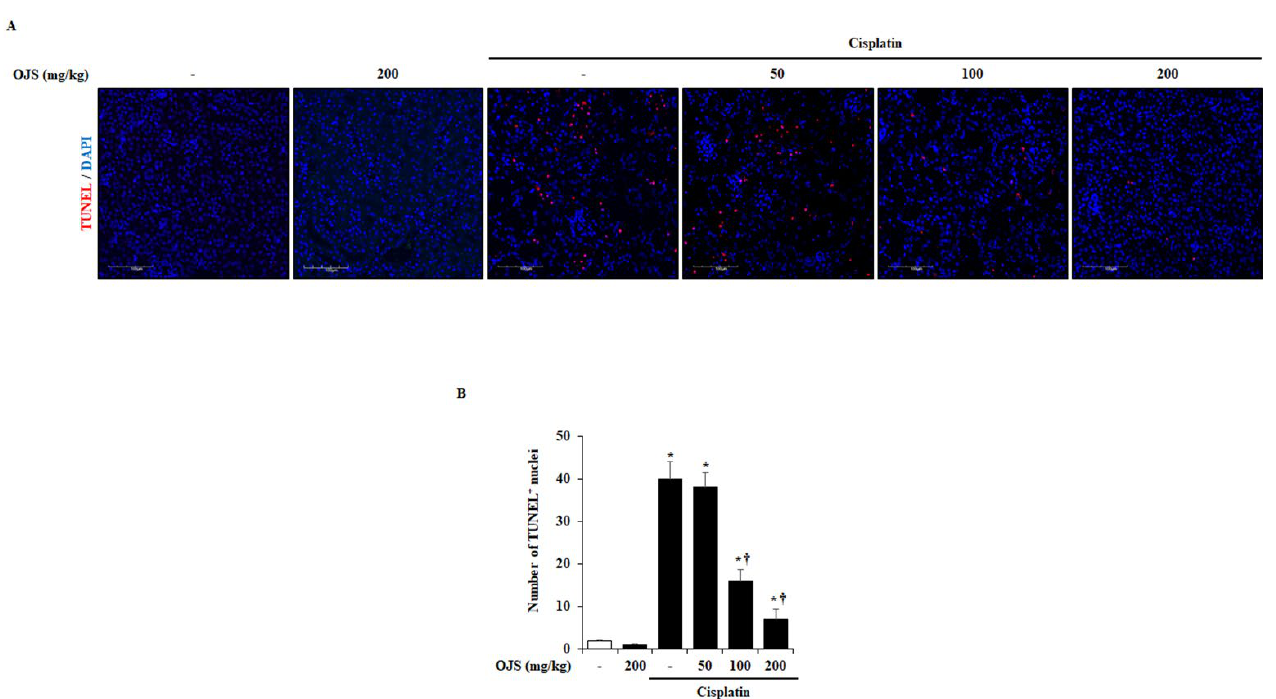
Figure 3. OJS decreases renal tubular cell death in cisplatin-induced AKI. ( A ) Representative TUNEL-stained sections of the kidney (200× magnification). ( B ) TUNEL-positive cells of the kidney were scored for red fluorescence. Each experiment was repeated 3 times. Data are represented as mean ± S.E.M. ( n = 12; * indicates p < 0.05 vs. saline-treated control group, † indicates p < 0.05 vs. cisplatin treatment alone).